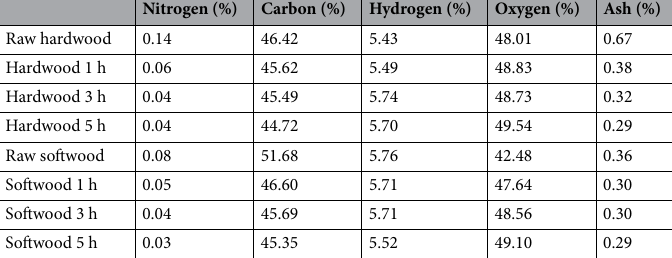
Table 3. Ultimate analysis (ash-free basis) of untreated and pretreated